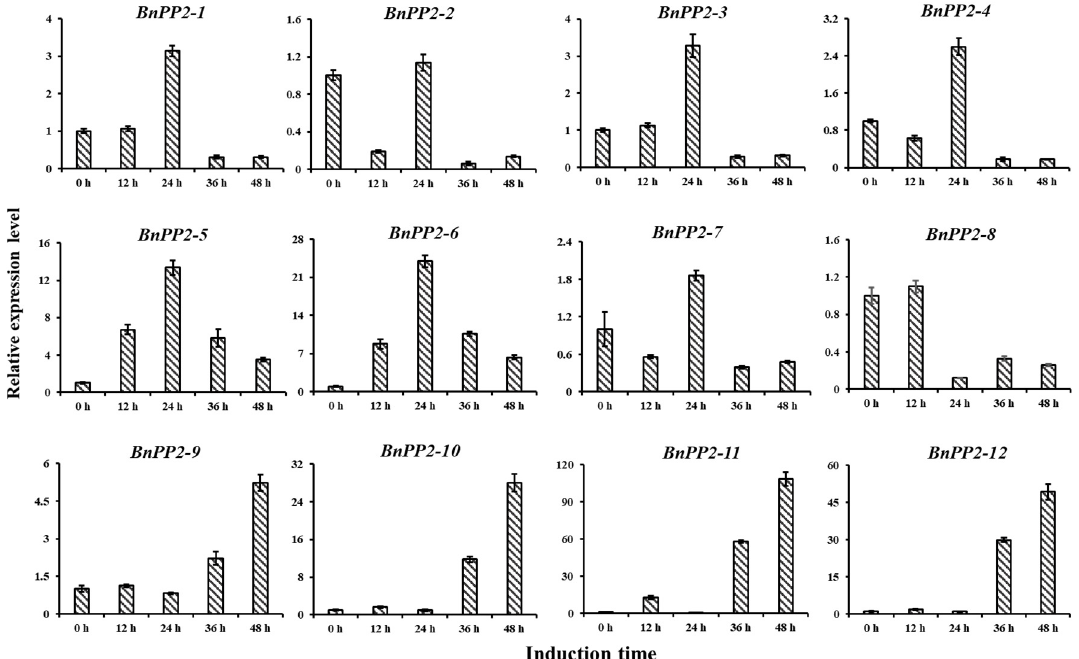
Figure 4. The expression validation of 12 candidate BnPP2 genes in response to S. sclerotiorum by qRT-PCR. The time points 0 h, 12 h, 24 h, 36 h and 48 h represent hours after inoculation with S. sclerotiorum . The error bars show the standard error of three replicates.